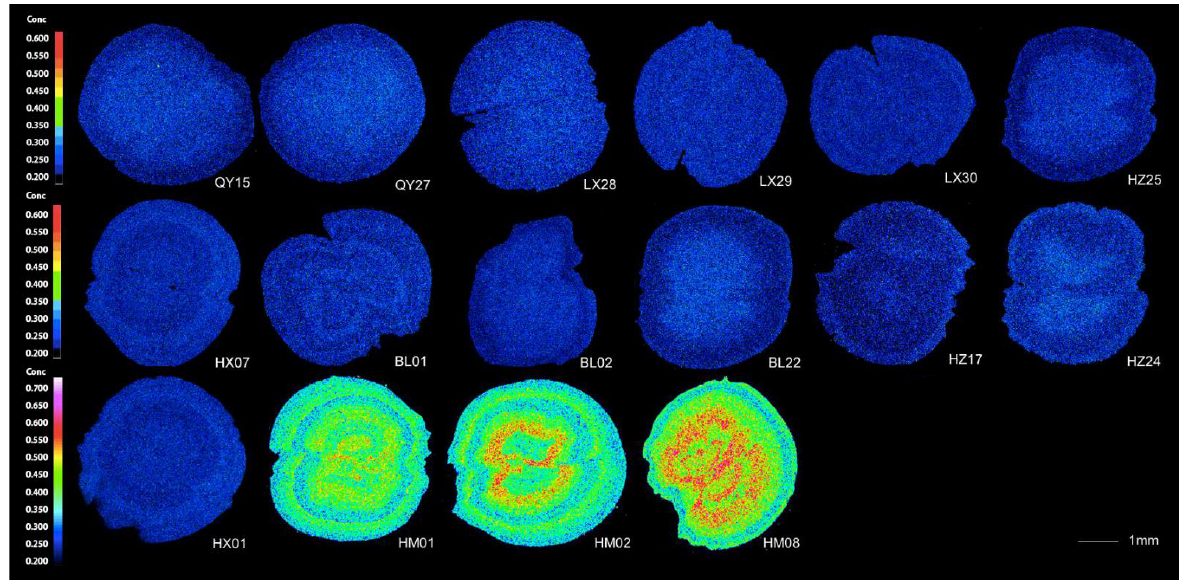
Figure 2. X-ray intensity maps of strontium (Sr) in the sagittal plane of the 16 representative otoliths of Coilia grayii collected from 6 populations; HX, HZ, and LX are located upstream of the dam while QY and BL are located downstream and HM is near the estuary. The uniform bluish pattern indicated a freshwater residence while the yellowish and reddish pattern suggested a brackish water origin.